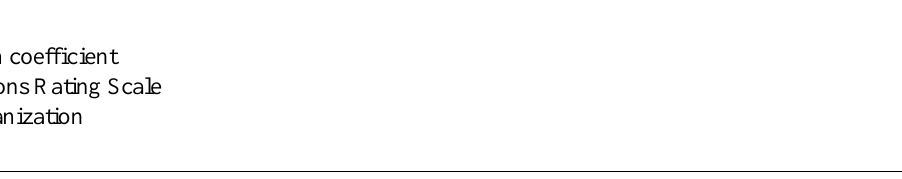
Abbreviations ICC: intraclass correlation coefficient MARS: Mobile Applications Rating Scale WHO: World Health